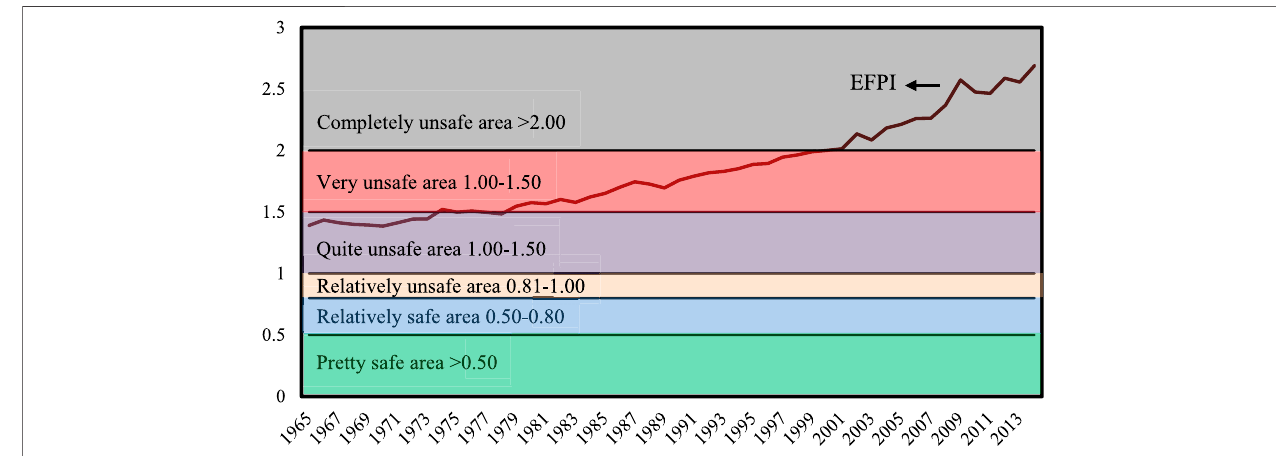
FIGURE 1 | Ecological situation in India.